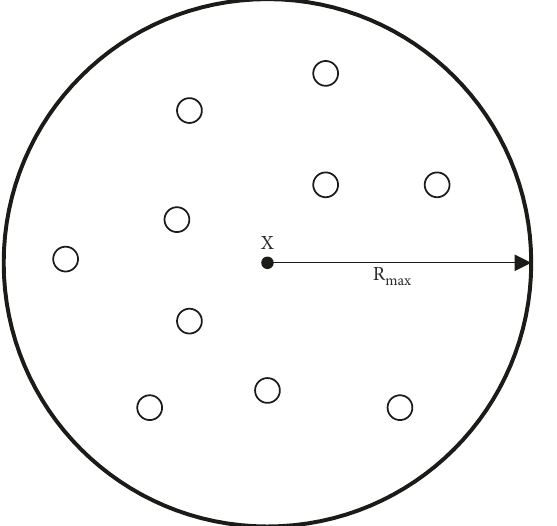
Figure 2: Weight function support domain.